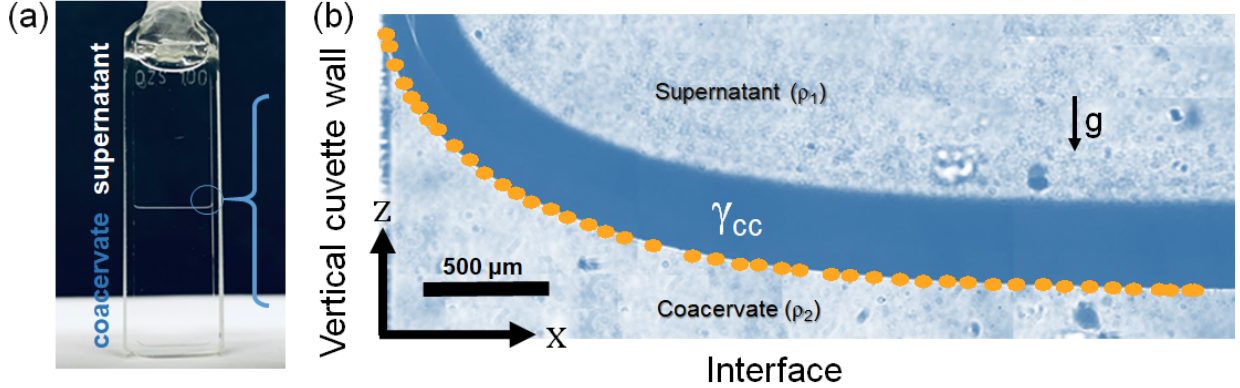
Figure 8. ( a ) Macroscopic phase separation obtained after 14 days after complexation of the PDADMAC/PANa system prepared from 18.6 mM PE solutions at charge stoichiometry (Z = 1). A clear separation between the dense coacervate phase and the macromolecule-depleted supernatant is visible. ( b ) Optical microscope image of the liquid–liquid interface near to the cell wall. The static interfacial profile was fitted (orange dots) to the generalize Laplace–Young equation (see Equation (2)) to extract the capillary length scale l c to compute the interfacial tension γ cc .